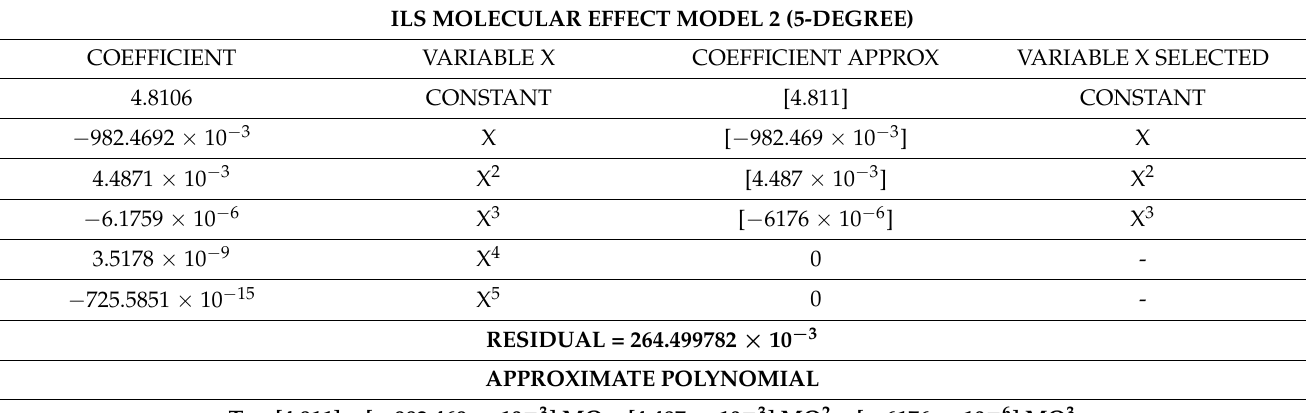
Table 6. Numerical results for the molecular effect model using the 5-degree polynomial method and the approximated equation. For the approximation, a cubic polynomial is